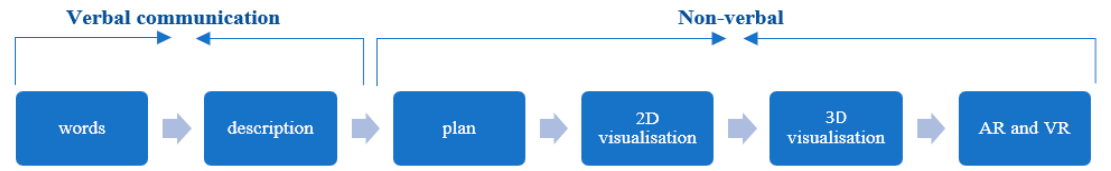
Figure 3. Development of tools for the presentation of planned spatial changes. Source: Prepared by the author.